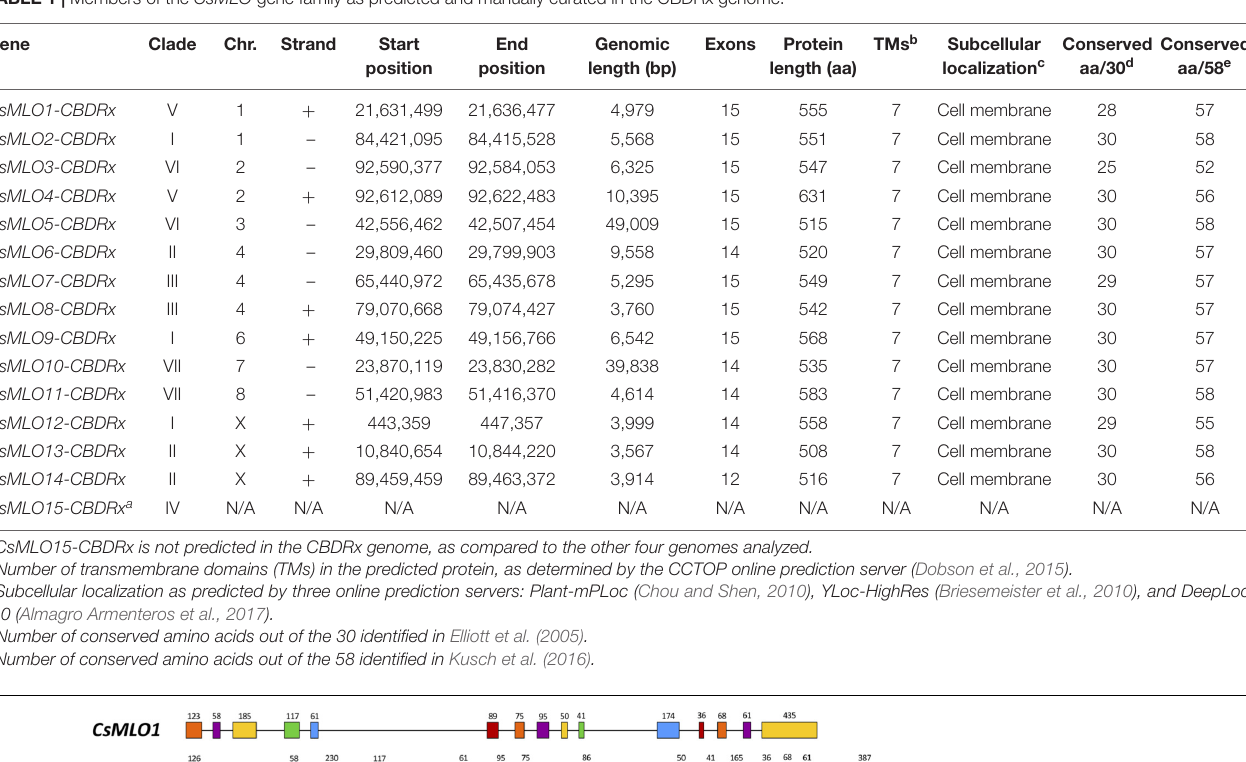
TABLE 1 | Members of the CsMLO gene family as predicted and manually curated in the CBDRx genome. Gene Clade Chr. Strand Start